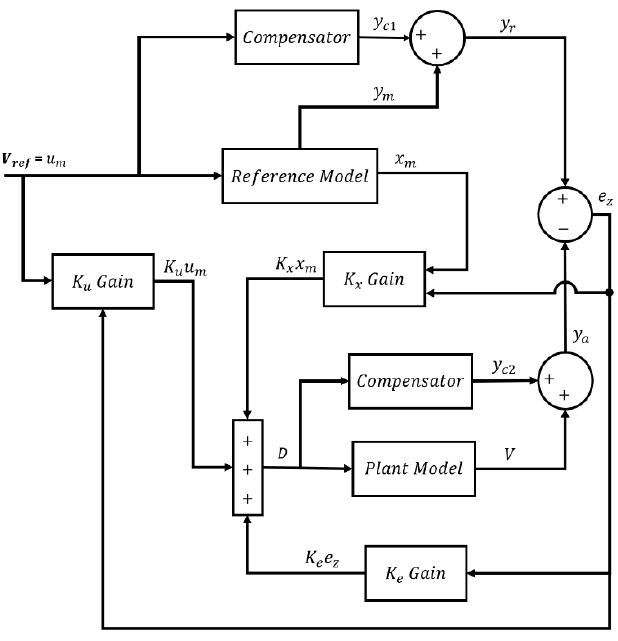
Figure 7. RDAC structure.